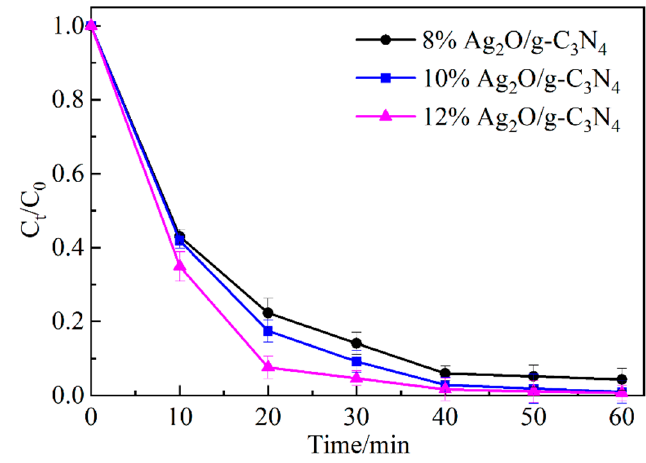
Figure 7. Degradation degree of MO under different Ag 2 O compound ratios.